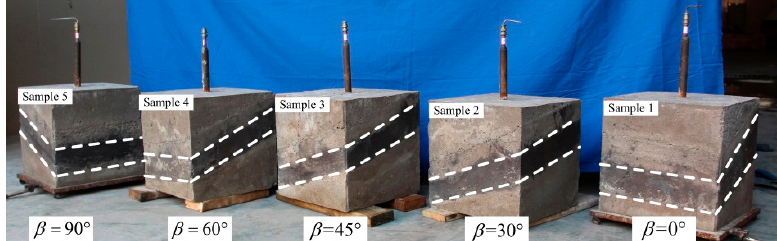
Figure 7. Photograph of five specimens used for hydraulic fracture testing. The specimens are 300 mm cubes and each has a fracturing pipe protruding from the top. The specimens were all made with the simulated coal seam dipping at 20° but each specimen was tested under a different principal stress (the “ β = x ” number shown for each specimen).